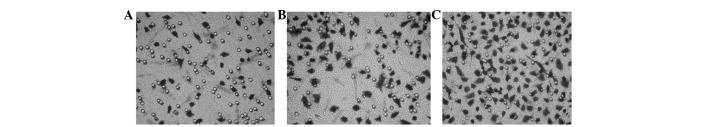
Transwell migration test. (A) Control; (B) FCM group; (C) CAFs group. FCM, cancer-associated fibroblast conditioned medium; CAF, cancer-associated fibroblast.